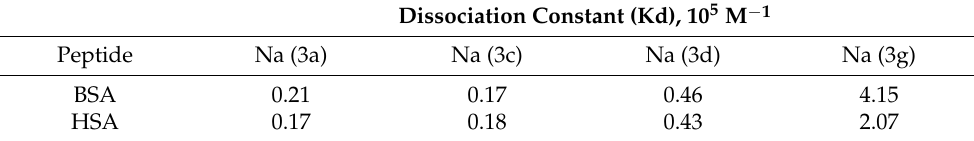
Figure 5. Fluorescence spectra of HSA ( λ ex = 330 nm) in complexes with Na (3g) (5 × 10 − 5 –1 × 10 − 4 M, pH 8.0). Inset: Fluorescence quenching in Stern–Volmer coordinates. Table 2. Dissociation constants (Kd) of closo -borate-albumin